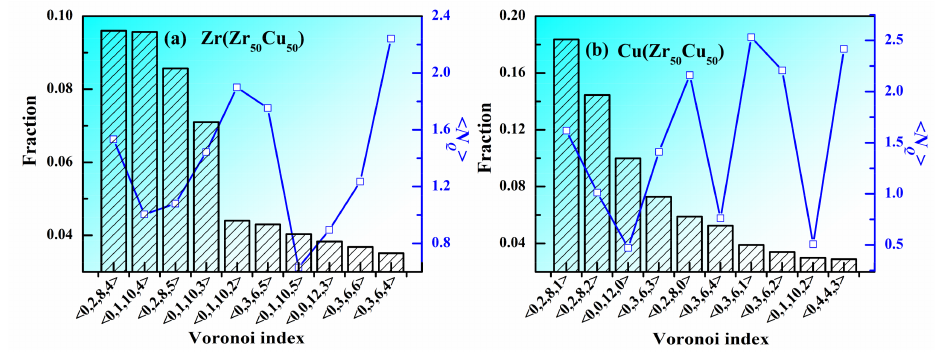
Figure 4. Fraction and < N Q > of top 10 Voronoipolyhedra in Zr 50 Cu 50 MG at 300 K. ( a ) Zr, ( b )